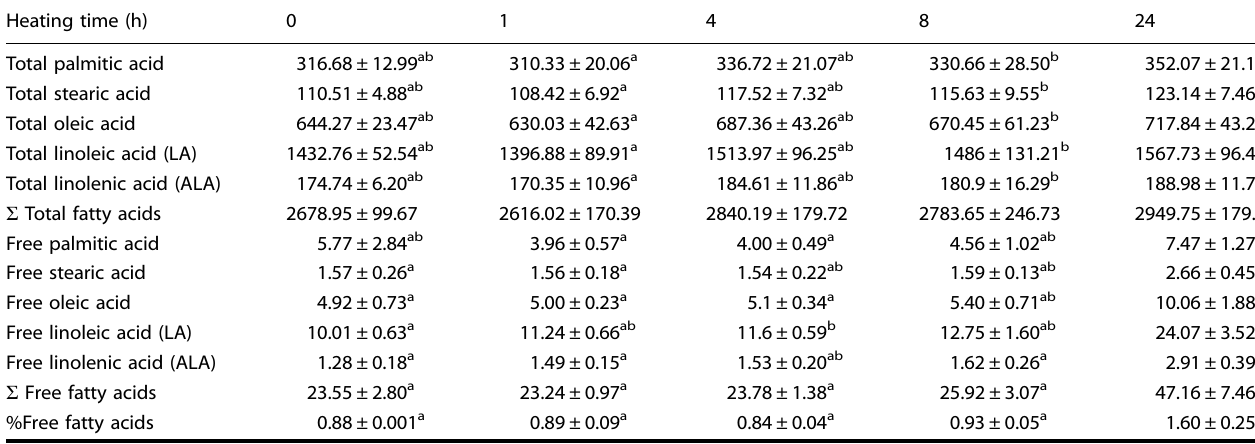
Data are expressed at mean ±SD of n = 5 per time-point. a – c Different letters within a row are signi fi cantly different by repeated measures one-way ANOVA followed by Tukey ’ s post-hoc test ( p <0.05).